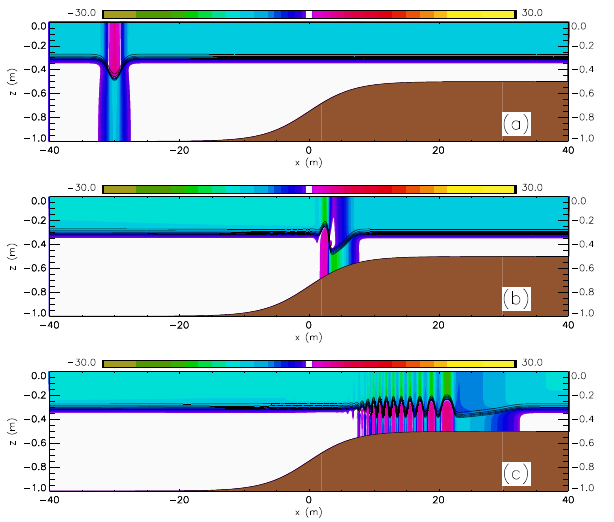
¯ U . Solid: their sum. dz